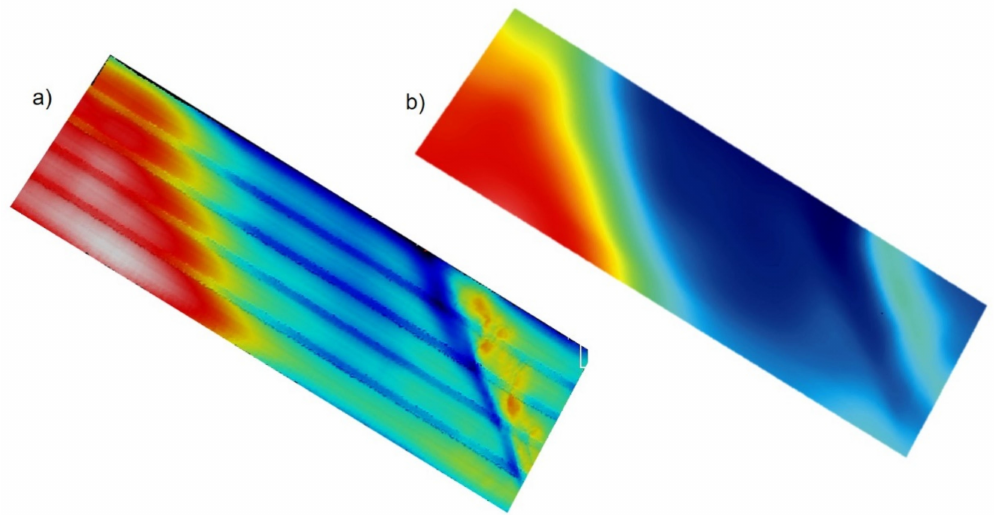
Figure 19. Depth distribution in the area obtained using the multibeam echosounder with the faulty SVS ( a ) and with the sensor installed according to a new technical solution ( b